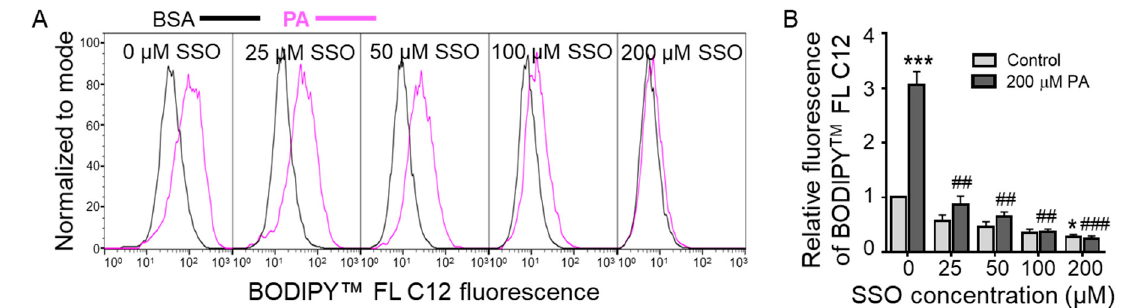
Figure 3. BODIPY TM FL C12 uptake in N2a cells pre-treated with sulfo-N-succinimidyl oleate (SSO) for 1 h followed by treatment with BSA or PA for 6 h. N2a cells were pre-treated with different concentrations of SSO for 1 h followed by treatment with 200 µM PA or BSA for 6 h, and FA uptake in these cells was determined by BODIPY TM FL C12 via flow cytometry with representative histograms shown in ( A ) and quantitated data shown in ( B ). Data presented were representative of three independent experiments. Data (Mean ± SEM) were analyzed using two-way ANOVA followed by Tukey’s multiple comparison test. * p < 0.05 vs. BSA control; *** p < 0.001 vs. BSA control; ## p < 0.01 vs. 200 µM PA; ### p < 0.001 vs. 200 µM PA.